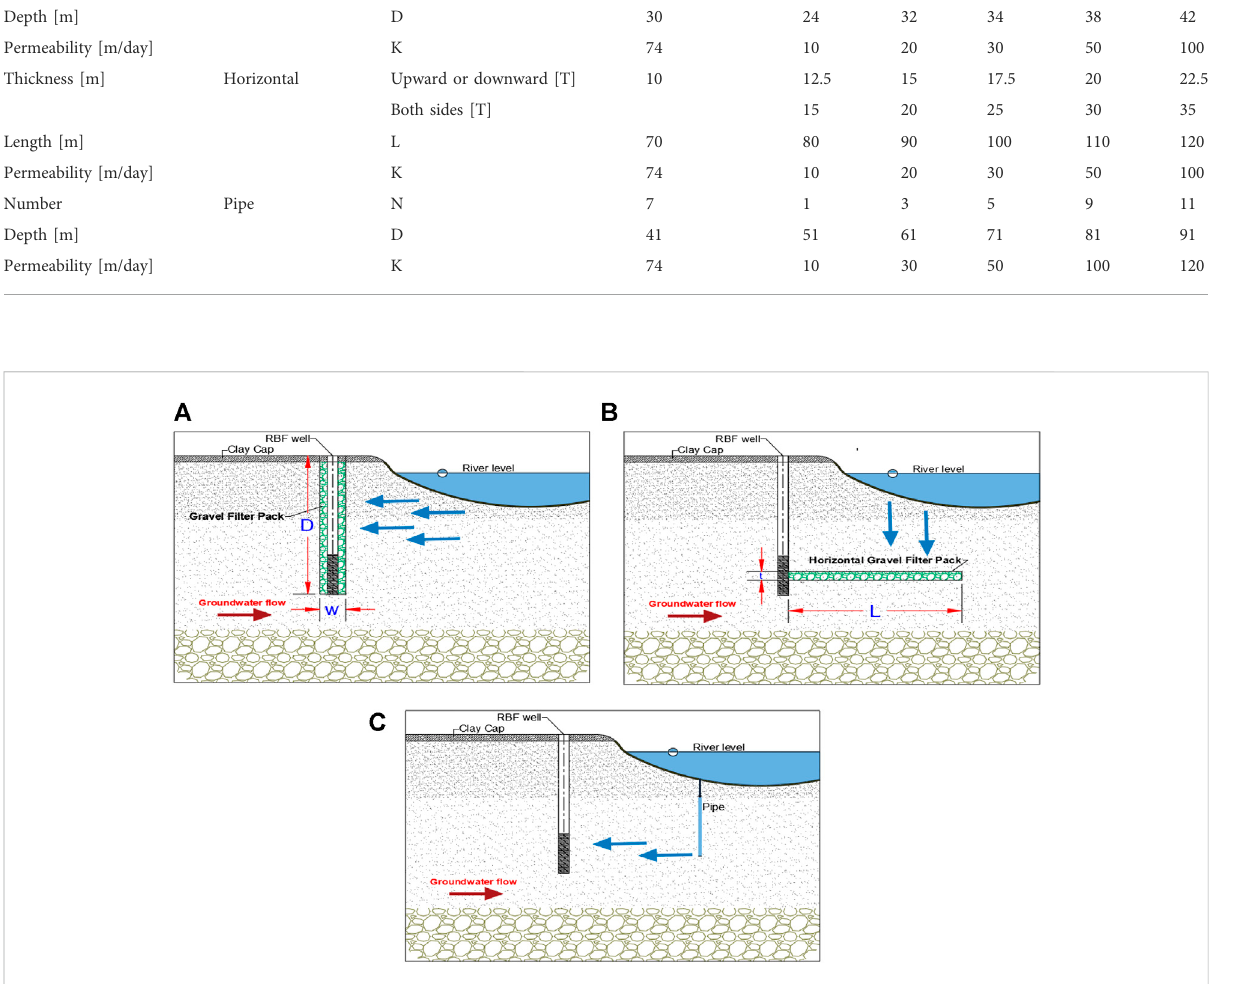
FIGURE 8 Proposed scenarios for the RBF gravel pack and pipe fi lter at the Embaba site are (A) vertical gravel fi lter, (B) horizontal gravel fi lter, and (C) pipe fi